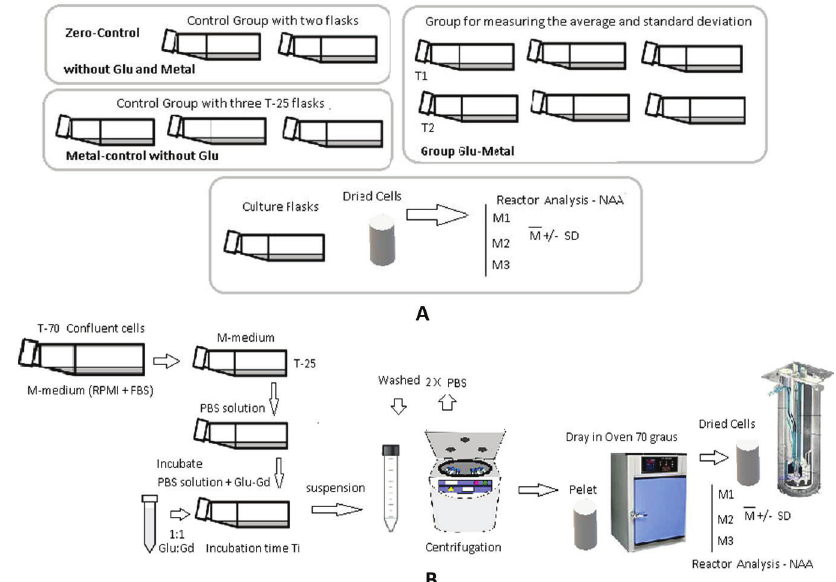
FIGURE 1 - (A) Representation of the flasks in the control groups (metal-control and zero control), and in the groups with glucose- metal incubation; (B) Illustration of the procedures used for measuring the metal concentration in dried samples, for each culture flask related to a specific incubation